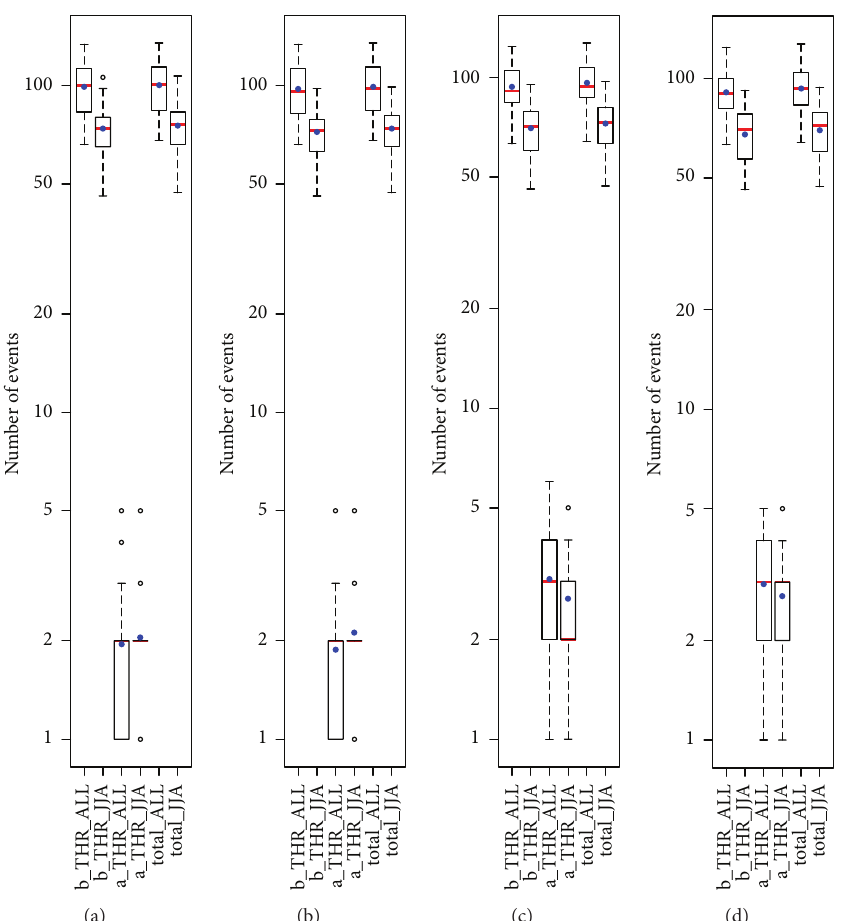
Figure 3: Boxplots for annual number of events averaged for one station: b THR ALL: events below THR for ALL, b THR JJA: events below THR for JJA, a THR ALL; events above THR for ALL, total ALL: total amount for ALL, and total JJA: total for JJA; (a) western 1966–2006, (b) western 1982–2006, (c) eastern 1966–2006, and (d) eastern 1982–2006.